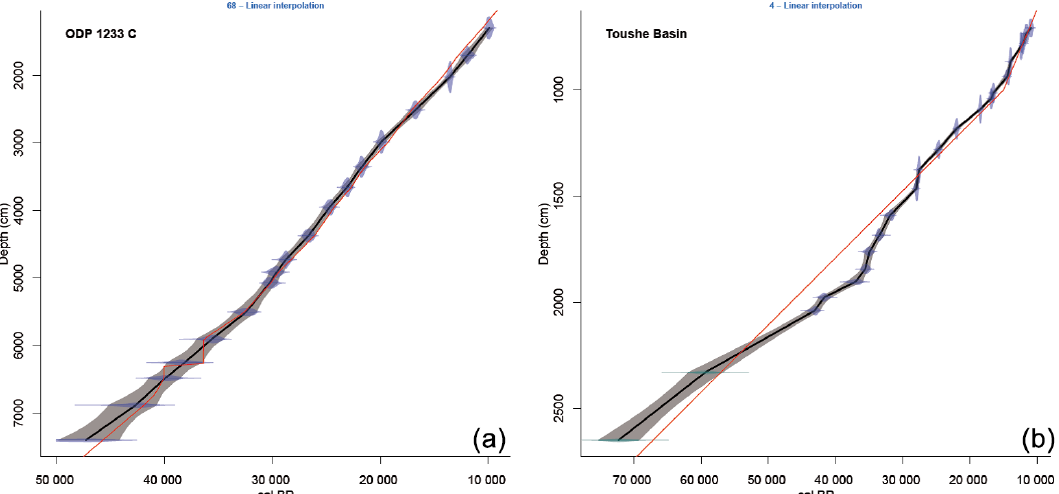
Figure 4. (a) Linear age model of the marine core ODP 1233 C and (b) linear age model of the terrestrial sequence Toushe (Taiwan). Red line: original age model with the control points. Black line: harmonized age model based on radiometric dating and event stratigraphy. Blue: calibrated 14 C distribution. Green: non- 14 C age distribution (Ar / Ar, OSL, event stratigraphy). Grey shading: age uncertainties.